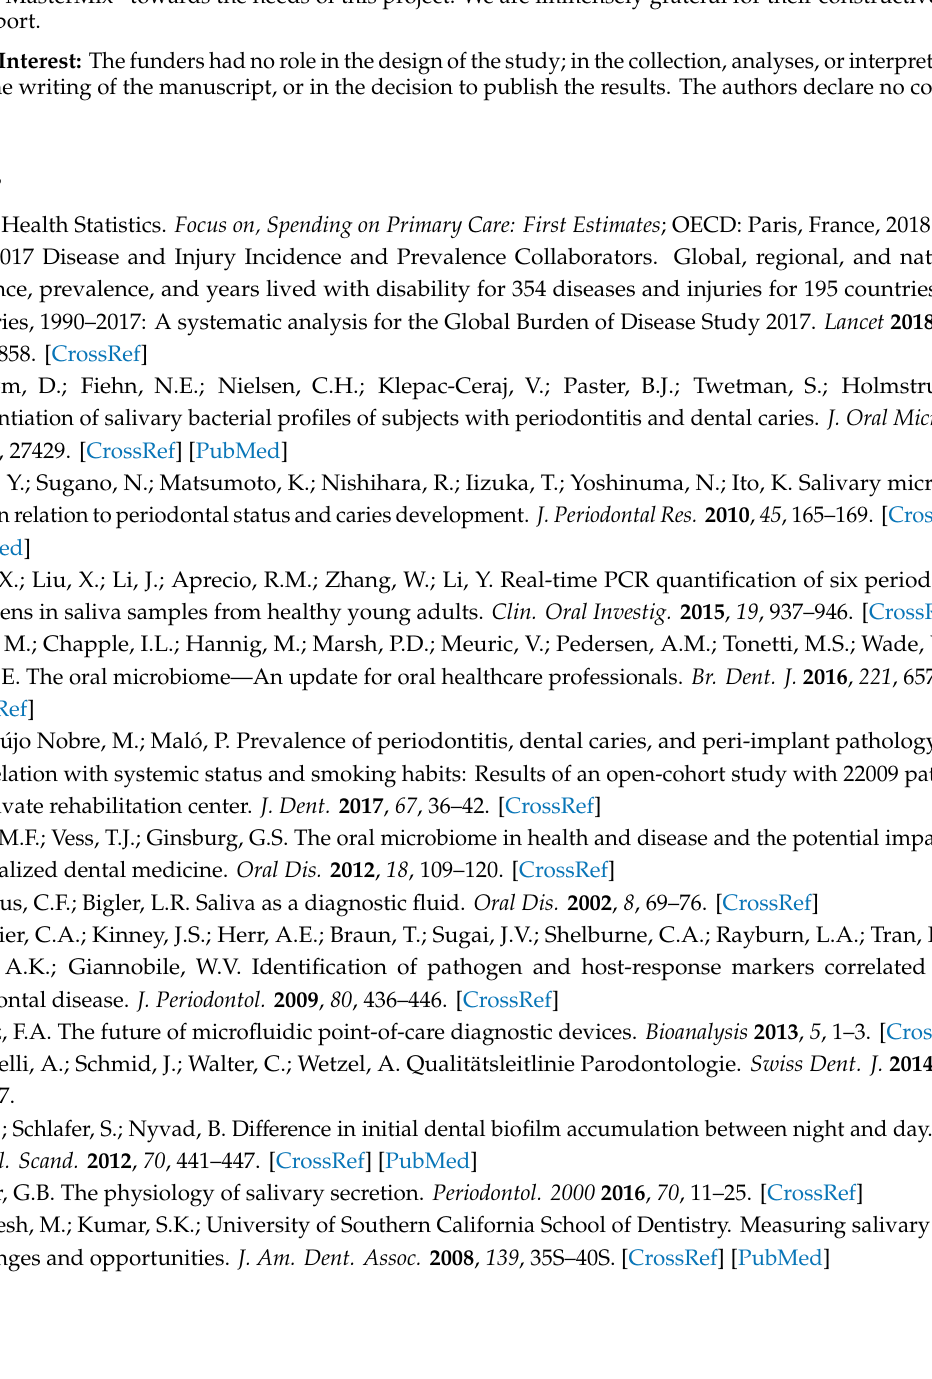
Figure S1. Duplex qPCR results of three consecutive PCR runs for all oral targets. Table S1: Data (triplets) of standard curves for all bacterial taxa; NC = negative